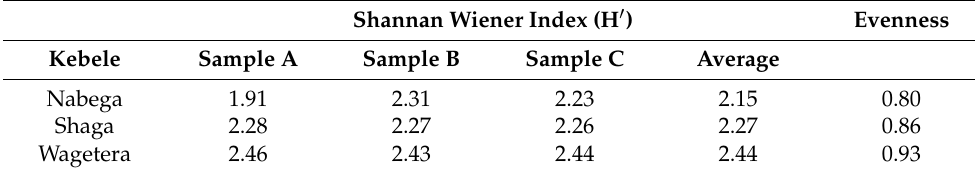
Table 9. Biodiversity of herbaceous vegetations in three Kebeles of Fogera